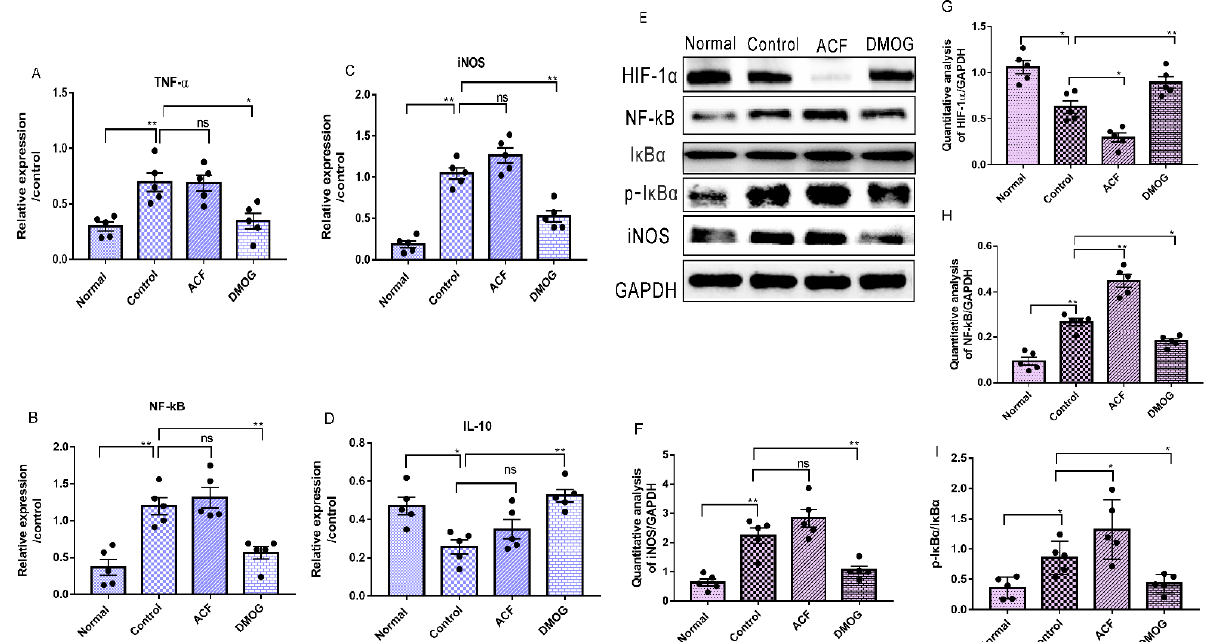
Figure 9. HIF-1 α activation alleviates brain damage via decreasing the expression level of pro-inflammatory cytokines.